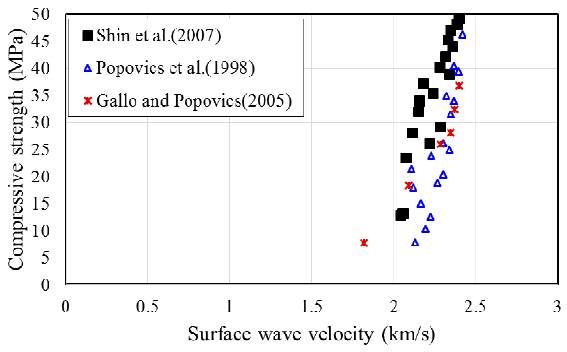
Figure 10. Existing data for hardened concrete.